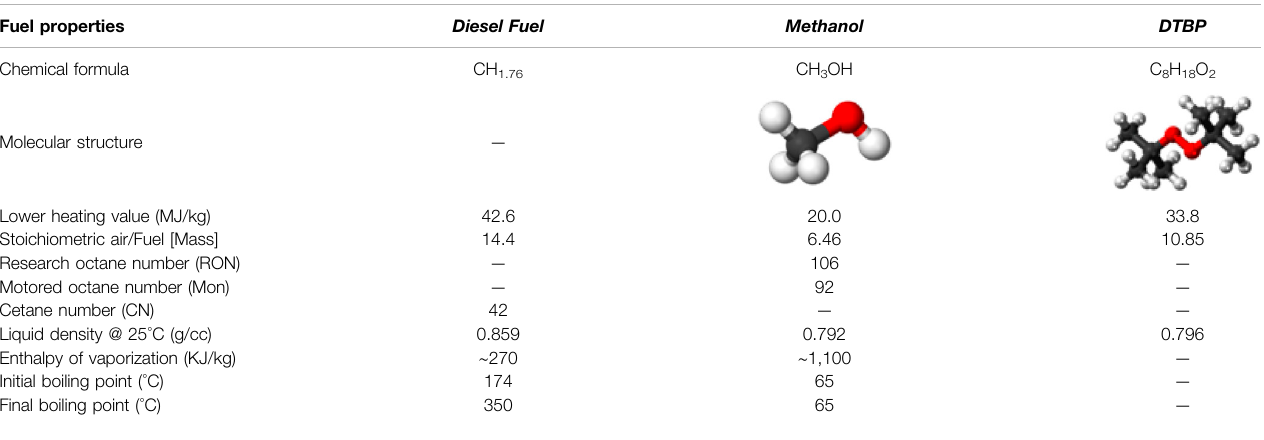
TABLE 2 | Fuel properties for pump diesel fuel, methanol, and di-tert-butyl peroxide (DTBP). Fuel